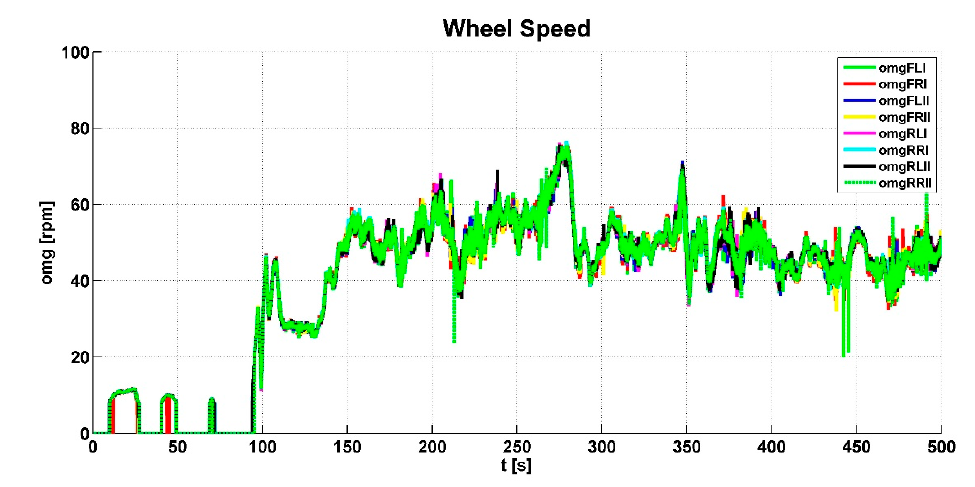
Figure 6. Pedal values.